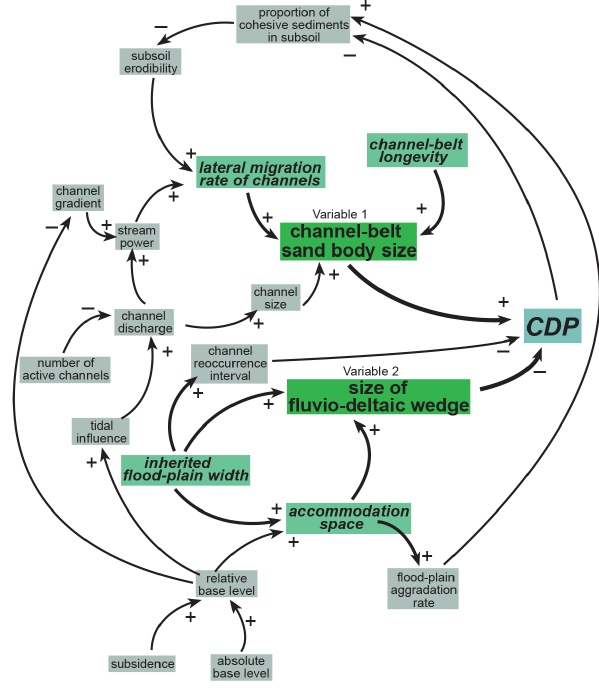
Figure 10. Causal loop diagram displaying the interrelated vari- ables for CDP. A plus sign indicates a positive relationship between variables (variables change in the same direction), and a minus sign indicates a negative relationship. CDP is calculated with two vari- ables (marked in green boxes): channel-belt sand body size and size of the fluvio-deltaic wedge. These in turn are largely determined by channel lateral migration rate, channel-belt longevity, accommoda- tion space and inherited floodplain geometry (width and topogra- phy) for which they are considered the key driving factors (green- blue boxes) explaining the relationship between CDP and down- stream distance from delta apex. See the text for a discussion of this relationship.